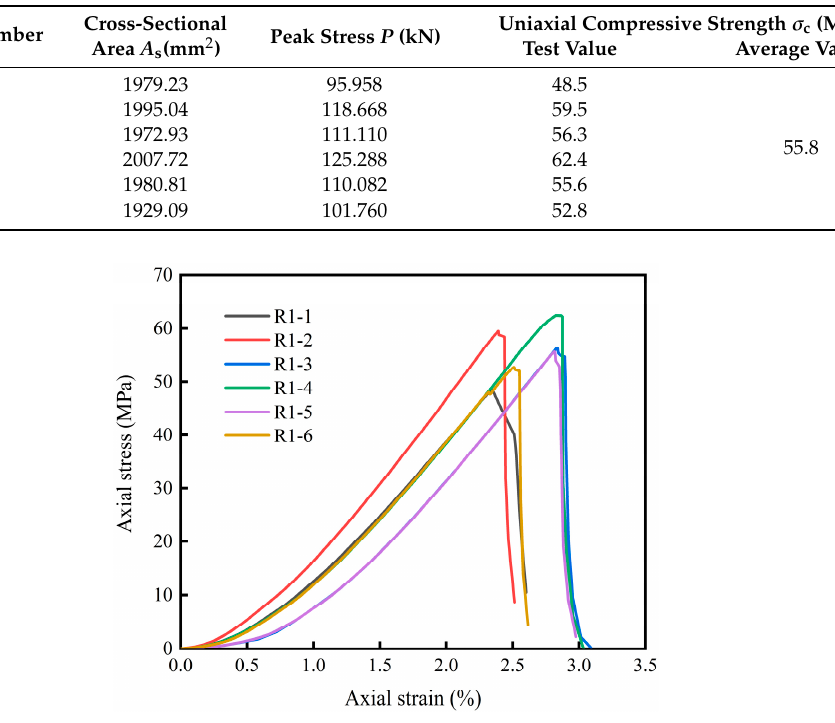
Table 3. Record table of uniaxial compressive strength (UCS) test.